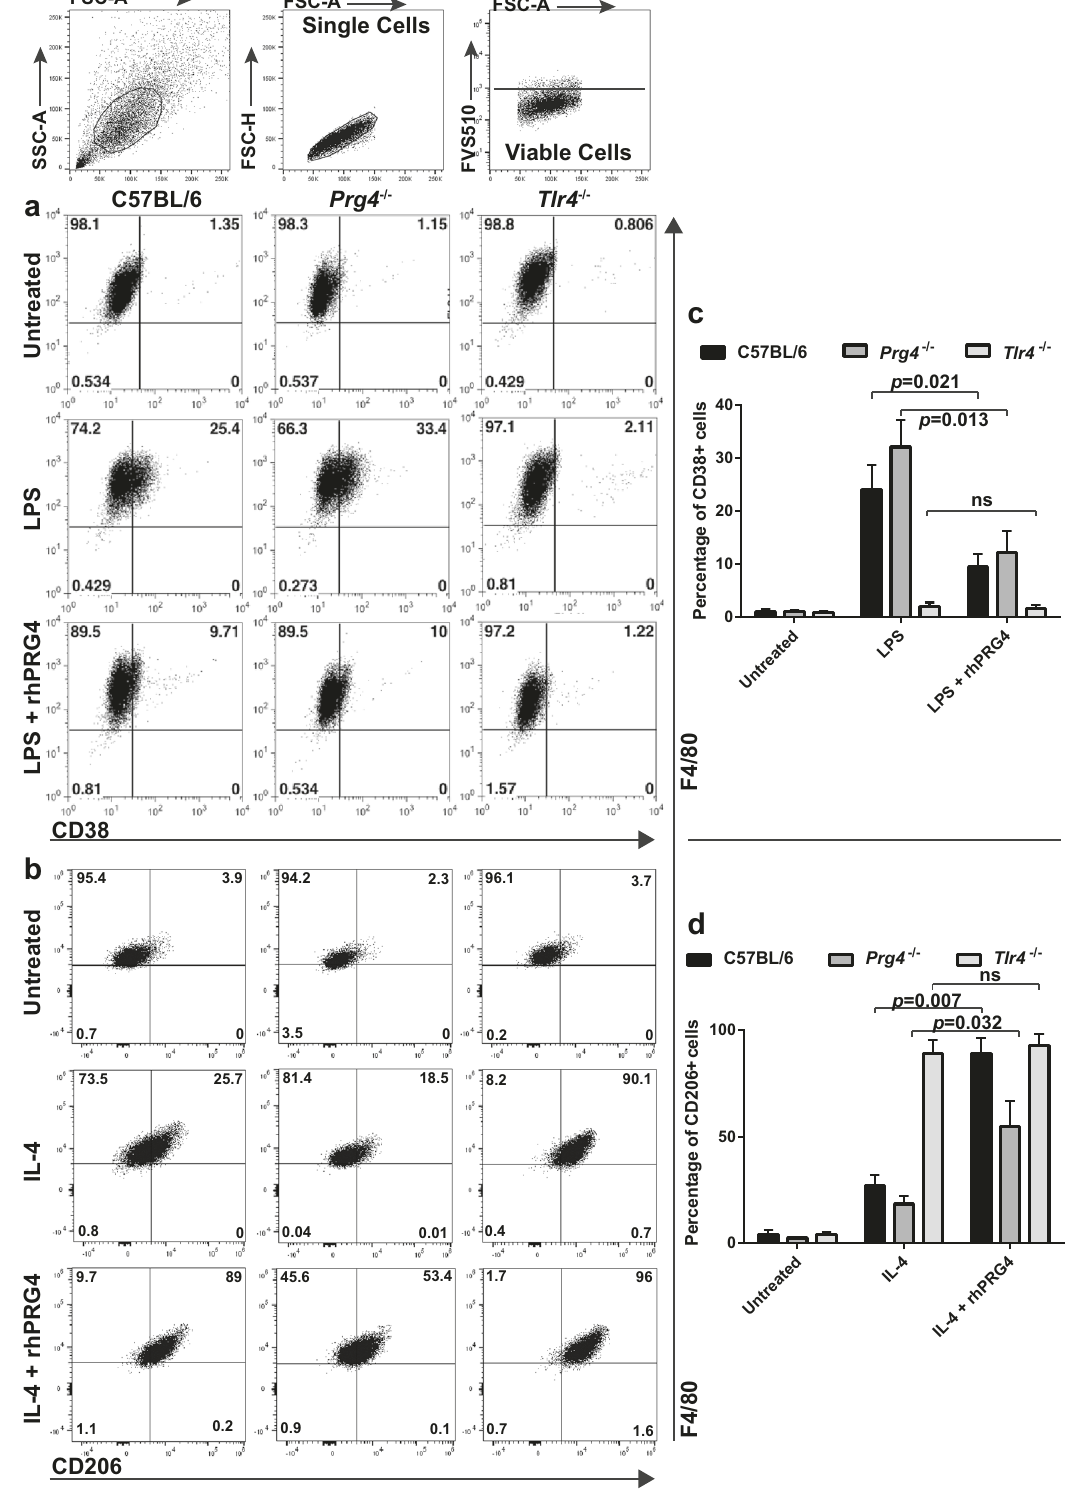
In vivo blood fl ow analysis Angiogenesis and blood fl ow analysis was measured by laser speckle imaging (Omegawave Inc, Japan) as done previously 76 . With the mouse under anesthesia, the imaging camera was focused such that the laser beam illuminated the entire dorsal surface of the ear. Perfusion